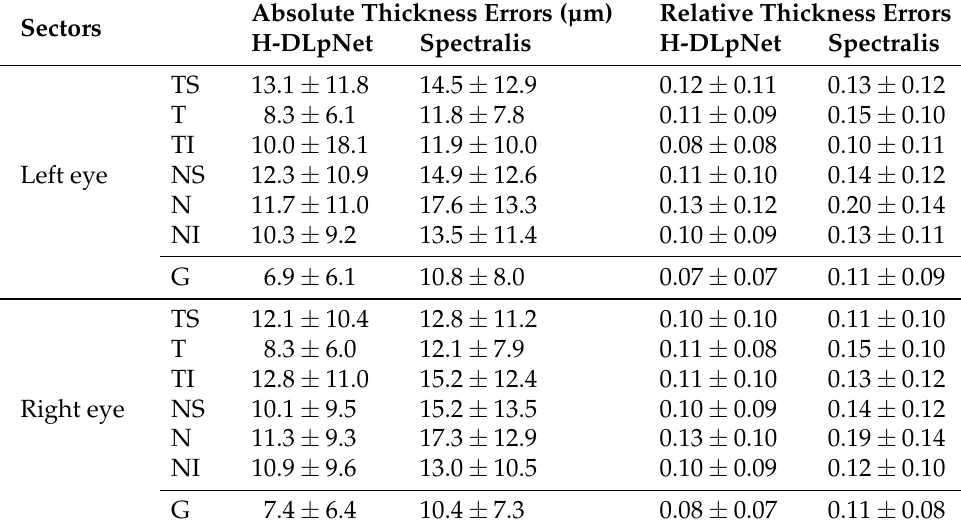
Table 5. Absolute thickness error (mean and standard deviation in µm) calculated as the difference of the RNFL thickness provided by the proposed approach to both H-DLpNet and Spectralis methods. Relative error (mean and standard deviation) computed for each sector as the absolute error divided by the thickness value determined by the proposed method. These values are calculated for each sector of the eye (TS, T, TI, NS, N, and NI) as well as for the whole layer